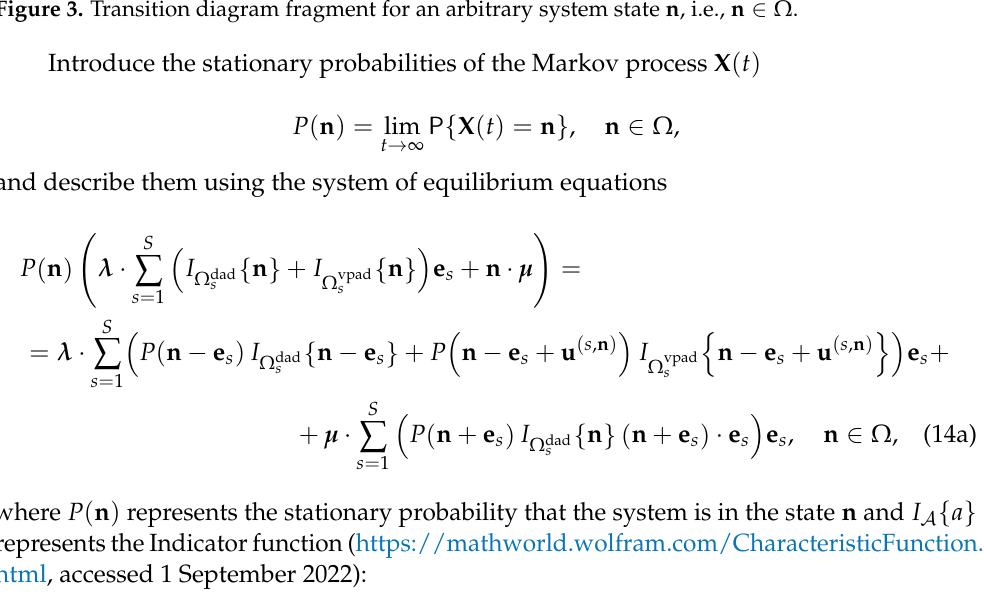
Figure 3. Transition diagram fragment for an arbitrary system state n , i.e., n ∈ Ω